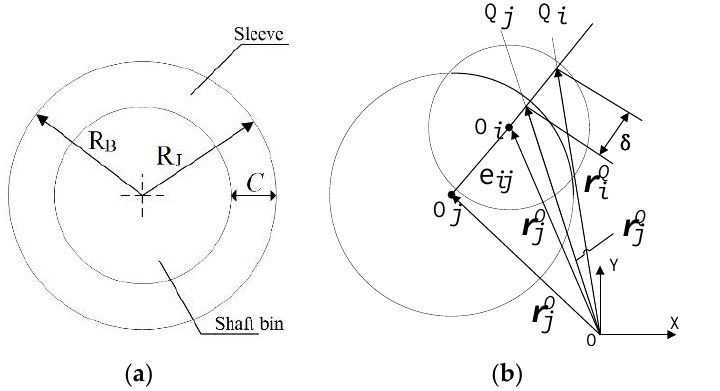
Figure 1. The relationship between shaft pin and sleeve: ( a ) Rotating pair with clearance; ( b ) Contact between shaft pin and sleeve.